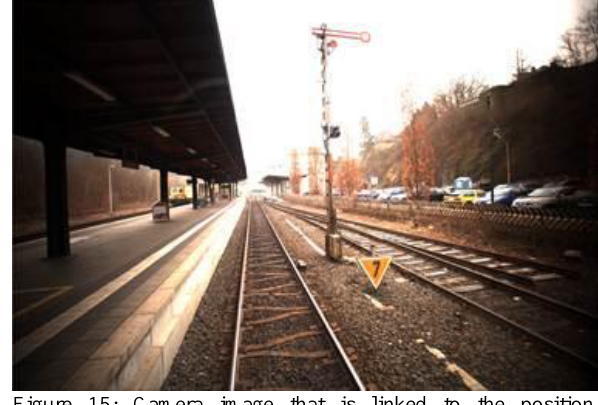
Figure 15: Camera image that is linked to the position documented in Figure 14